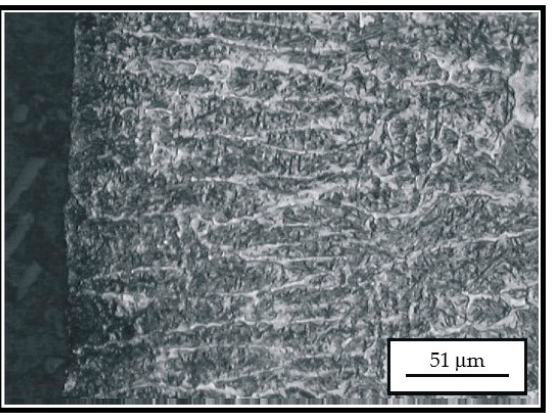
Figure 7. Appearance of microstructure of the hard-faced sample obtained by the Castolin 2 filler metal.